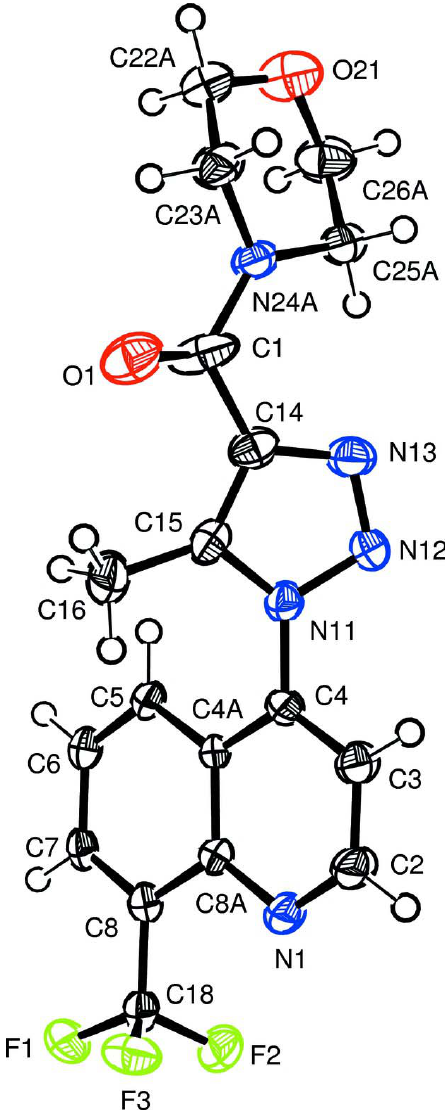
The molecular structure of the title compound, showing the atom-numbering scheme and displacement ellipsoids drawn at the 50% probability level. H atoms are shown as small spheres of arbitrary radius. Only the major component is